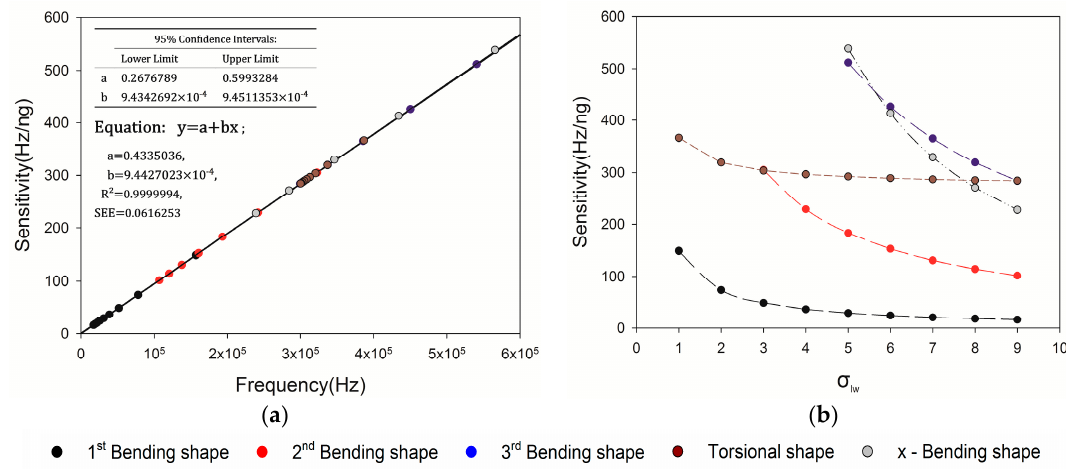
Figure 7. Mass sensitivity of MCLs structure. ( a ) Linear fit of mass sensitivity and resonant frequency of MCLs. ( b ) Sensitivity changes with different σ lw of MCLs.